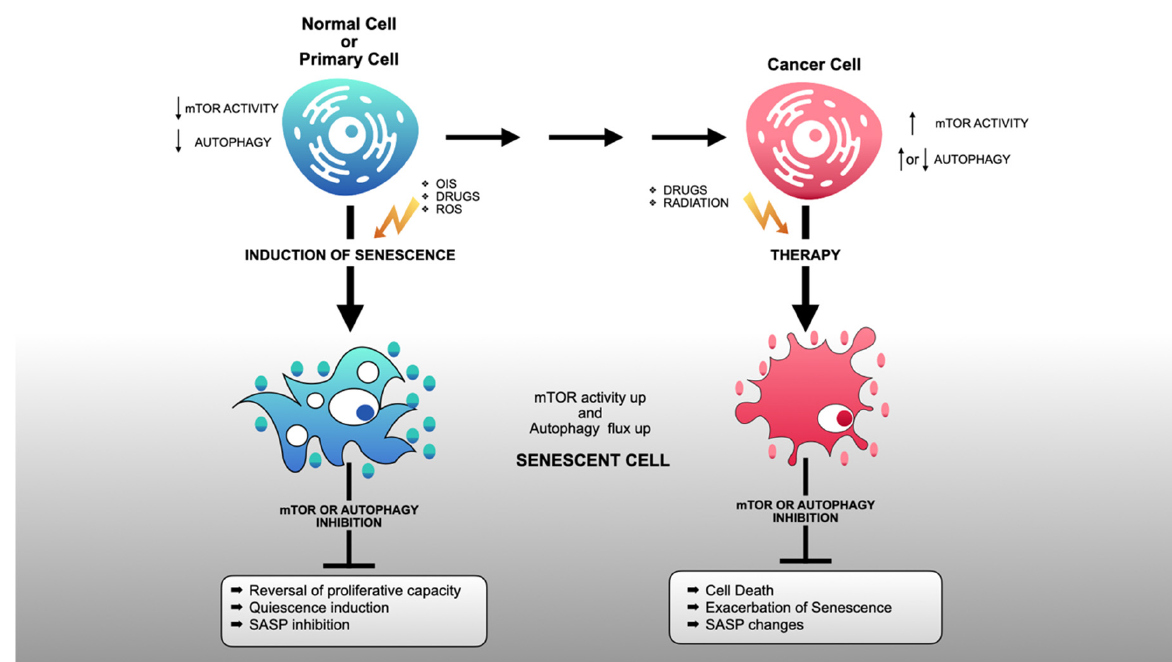
Figure 2. The effects of inhibiting autophagy or mTORC1 in primary or cancer cells undergoing senescence. Senescent cells subjected to mTORC1 or autophagy inhibition can have different fates depending on the senescence-inducing stimulus and tumorigenic status. As illustrated at the top of the figure, normal or primary cells contain generally reduced, although variable, basal levels of mTORC1 activity and autophagy. In contrast, most fully transformed—and genomically unstable—cancer cells are characterized by high levels of mTORC1 activity and variable levels of autophagy. The dynamic variation in the levels of autophagy in cancer cells likely reflects the effects of oncogenic stress and the metabolic challenges encountered at the tumor microenvironment. As shown in the middle of the figure, induction of senescence in normal (diploid) primary cells is generally accompanied by an upregulation of both mTORC1 activity and autophagy. Autophagy in this setting may be functionally coupled to mTORC1-dependent synthesis of SASP components, a functional interaction that is required for the implementation of the senescence program. As a consequence, inhibition of mTORC1 or autophagy can block senescence altogether or specifically abrogate the synthesis of SASP components. Unlike primary cells, cancer cells rendered senescent by pro-senescence chemotherapeutic drugs upregulate autophagy while retaining high levels of mTORC1 activity. In this setting, mTORC1 and autophagic activities may be functionally uncoupled, with each activity contributing independently to the maintenance or survival of senescent cells. As a consequence, inhibition of mTORC1 or autophagy would be expected to reduce the survival of senescent cells, exacerbate the senescence phenotype, or lead to more subtle changes in SASP profiles, depending on the biological context. Small arrows pointing up mean increased activity and small arrows pointing down mean decreased activity.